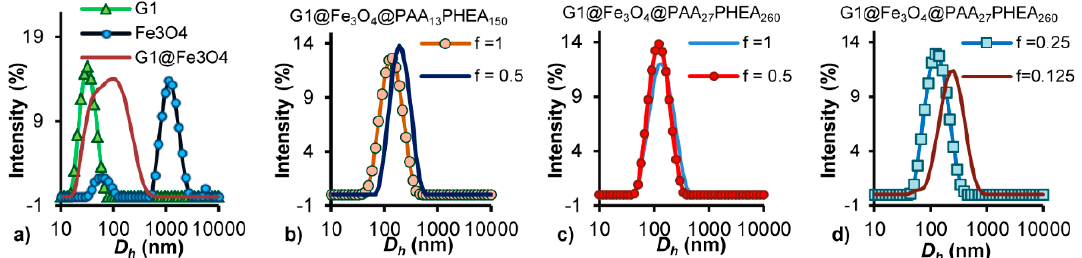
Figure 1. Hydrodynamic size distribution for ( a ) G1 (pH 4), Fe 3 O 4 (pH 1.4) and G1@Fe 3 O 4 (pH 1.4). ( b – d ) MPIC micelles G1@Fe 3 O 4 @PAA-b-PHEA (pH 7) for different f ratios at 25 °C.